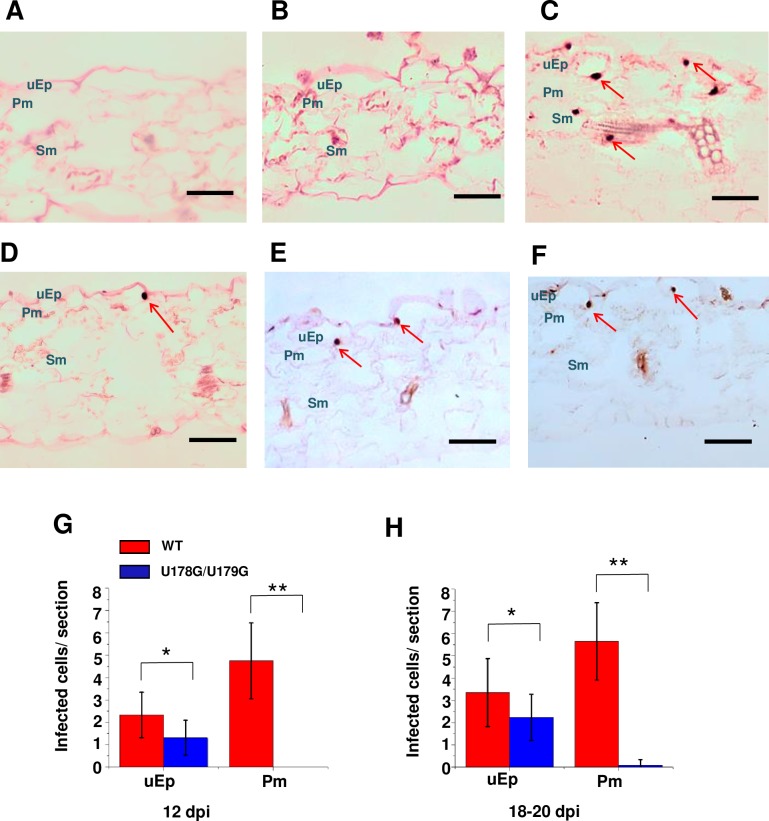
U178G/U179G fails to exit epidermal cells in rub-inoculated leaves.Transverse section (12 μm) in situ hybridization of (A) mock inoculated leaves (negative control), (B) leaves inoculated with replication defective A271G/C273G (negative control), (C) wild type PSTVd (positive control), and (D-F) U178G/U179G. Images for PSTVd WT and U178G/U179G are representative of more than 200 sections. Purple dots (red arrows) are viroid hybridization signals in nuclei. uEp, upper epidermis; Pm, palisade mesophyll; Sm, spongy mesophyll; lEp, lower epidermis. Bars = 100 μm. (G and H) Number of infected cells per leaf section (~1 x 0.15 mm) in the upper epidermis (uEp) or adjacent palisade mesophyll (Pm) of plants inoculated with WT PSTVd (red) or U178G/U179G (blue) at 12 dpi (G) and 18–20 dpi (H). Data were compiled from 40 sections obtained from 20 infected plants. Asterisks indicate significant differences (p < 0.05*; p < 0.01**) as determined by Student's t test. Bars indicate standard error of the mean.